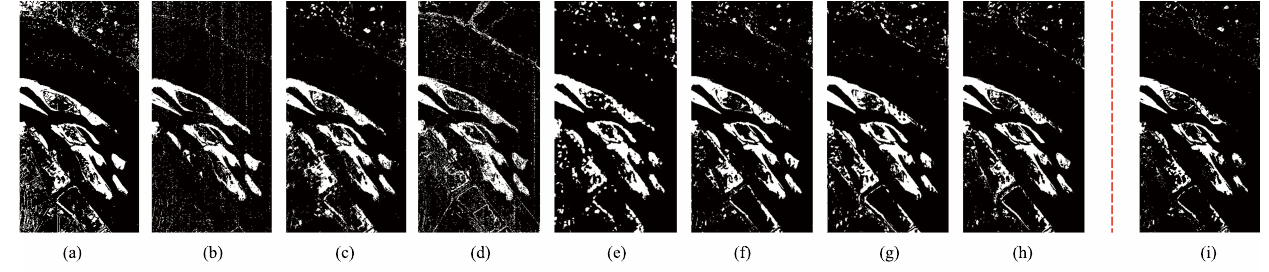
Figure 12. The change map results of different methods on the Irrigated Agriculture Dataset. ( a ) CVA. ( b ) SVM. ( c ) GETNET. ( d ) DSFANet. ( e ) WCRN. ( f ) Without FRL. ( g ) Without PS 2 A. ( h ) TFR-PS 2 ANet. ( i ) Ground truth.